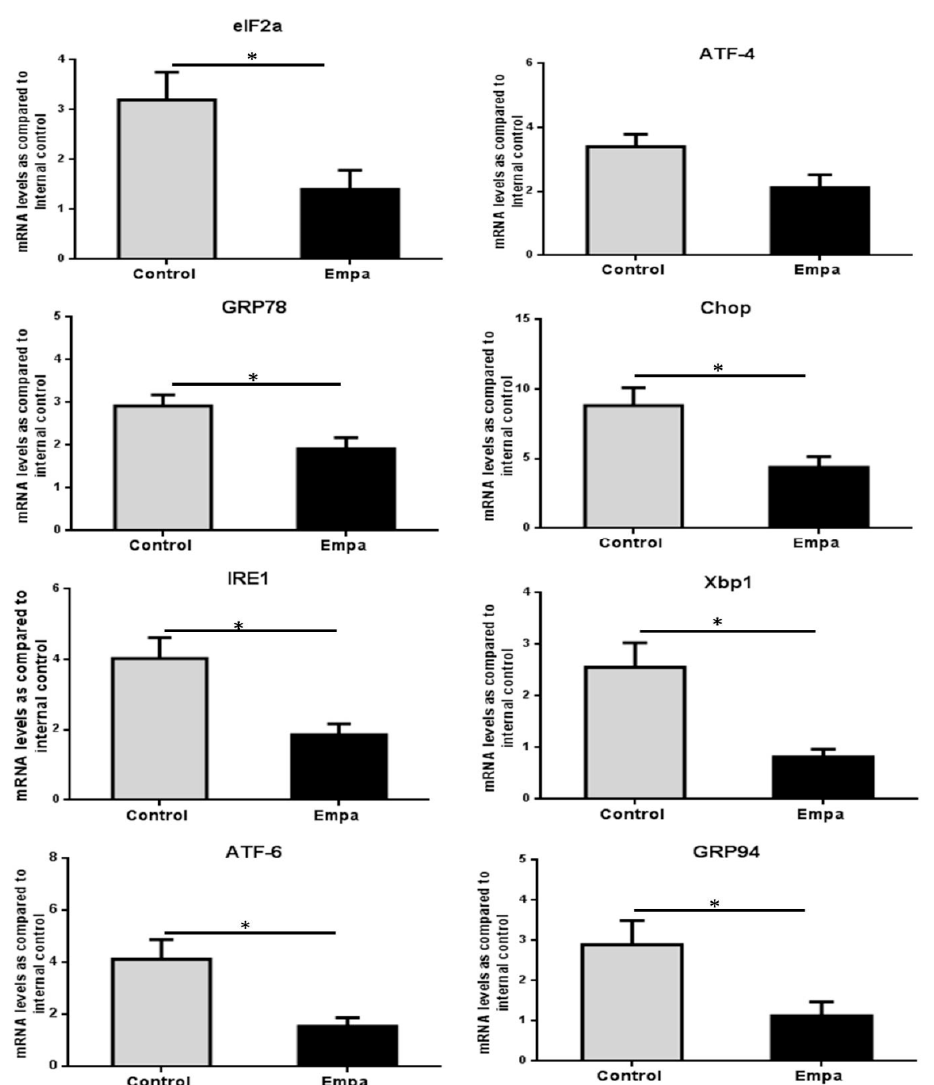
Figure 4. Changes of ER stress core genes mRNA levels after five weeks of empagliflozin/vehicle oral administration in the liver of ApoE (-/-) mice. The mRNA levels of elf2 α , ATF-4 , GRP78 , CHOP , IRE1 , XbP1 , ATF-6 and GRP94 were significantly reduced after five weeks of empagliflozin treatment. Data are shown as the mean ± SEM (*: p < 0.05).